Question: What kind of plot is shown here?
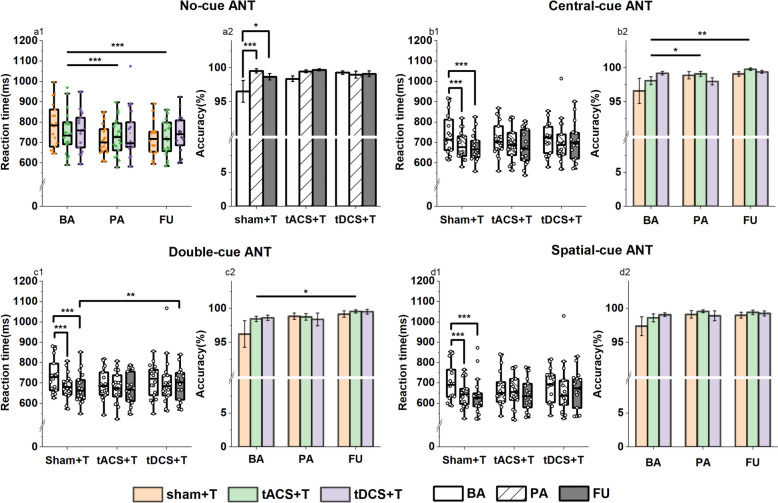
Answer: box